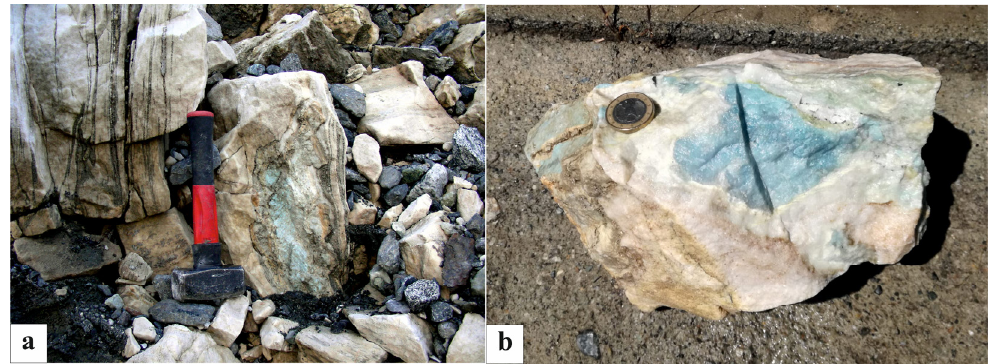
Figure 4. ( a ) Erratic pebble from the right side of the Sissone valley; ( b ) sample of marble lenseshowing the blue diopside in the core and the rims of white tremolite.